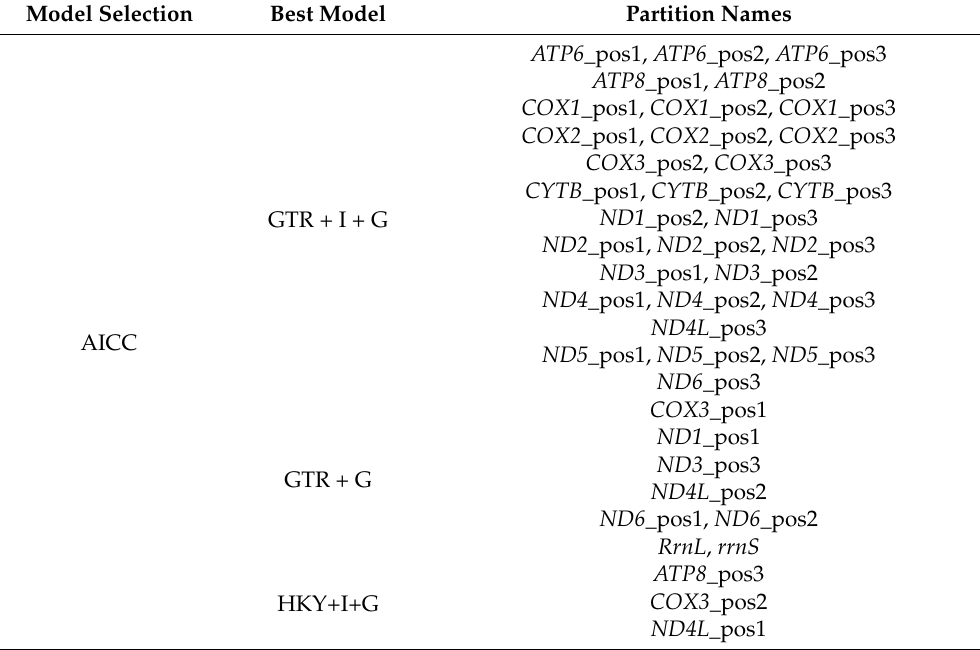
Table 1. The best-fitting models used for the phylogenetic analyses. Model Selection Best